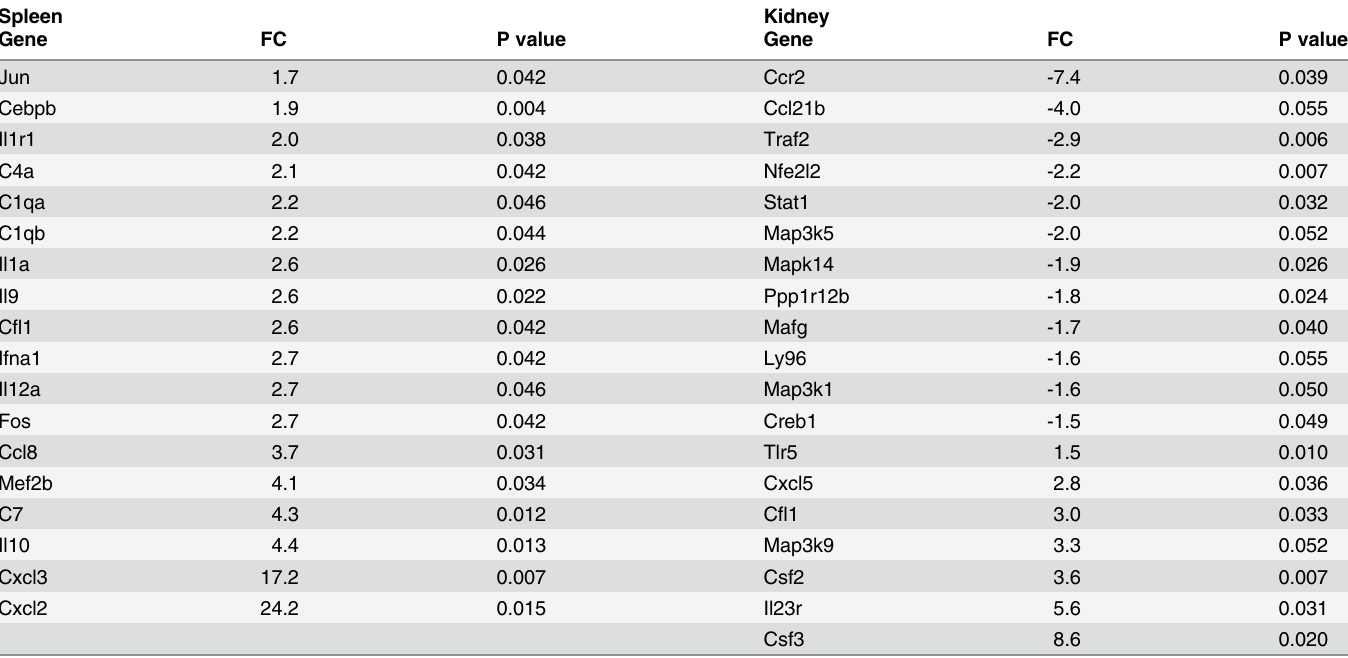
Genes with > 1.5-fold difference in mRNA expression between infected cd47 -/- and WT tissues and P-values < 0.05 are shown. FC: fold change in mRNA expression in infected cd47 -/- versus